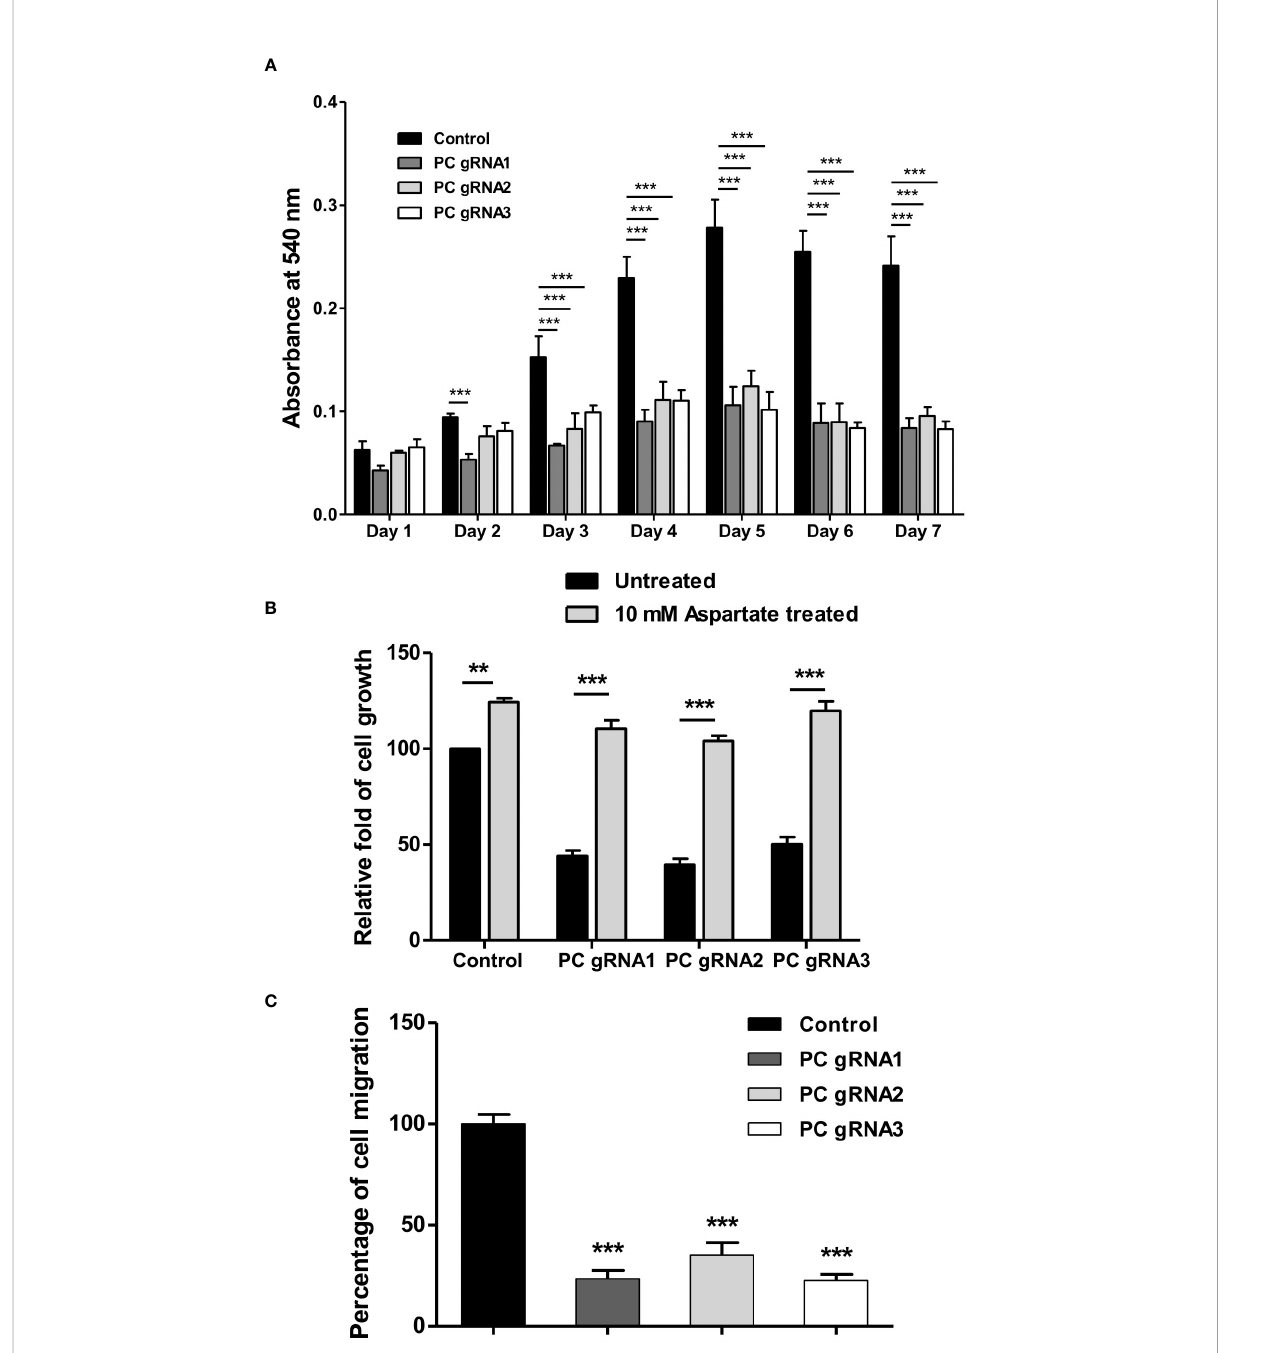
FIGURE 3 Impaired growth and cell migration of PC KO HT-29-cells. (A) Growth rate of PC KO HT-29 cells assessed by MTS assay over 7 days. (B) Restoration of growth of PC KO HT-29 cell lines with 10 mM aspartate for 48 h. (C) Percentage of migration ability of PC KO HT-29 cells relative to HT-29 transfected with empty vector (control), which was arbitrarily set to 100%. Cells were allowed to migrate through transwell over 48 h. The results were obtained from three independent experiments, and the statistical analysis was conducted using one-way ANOVA where **p < 0.01, ***p <